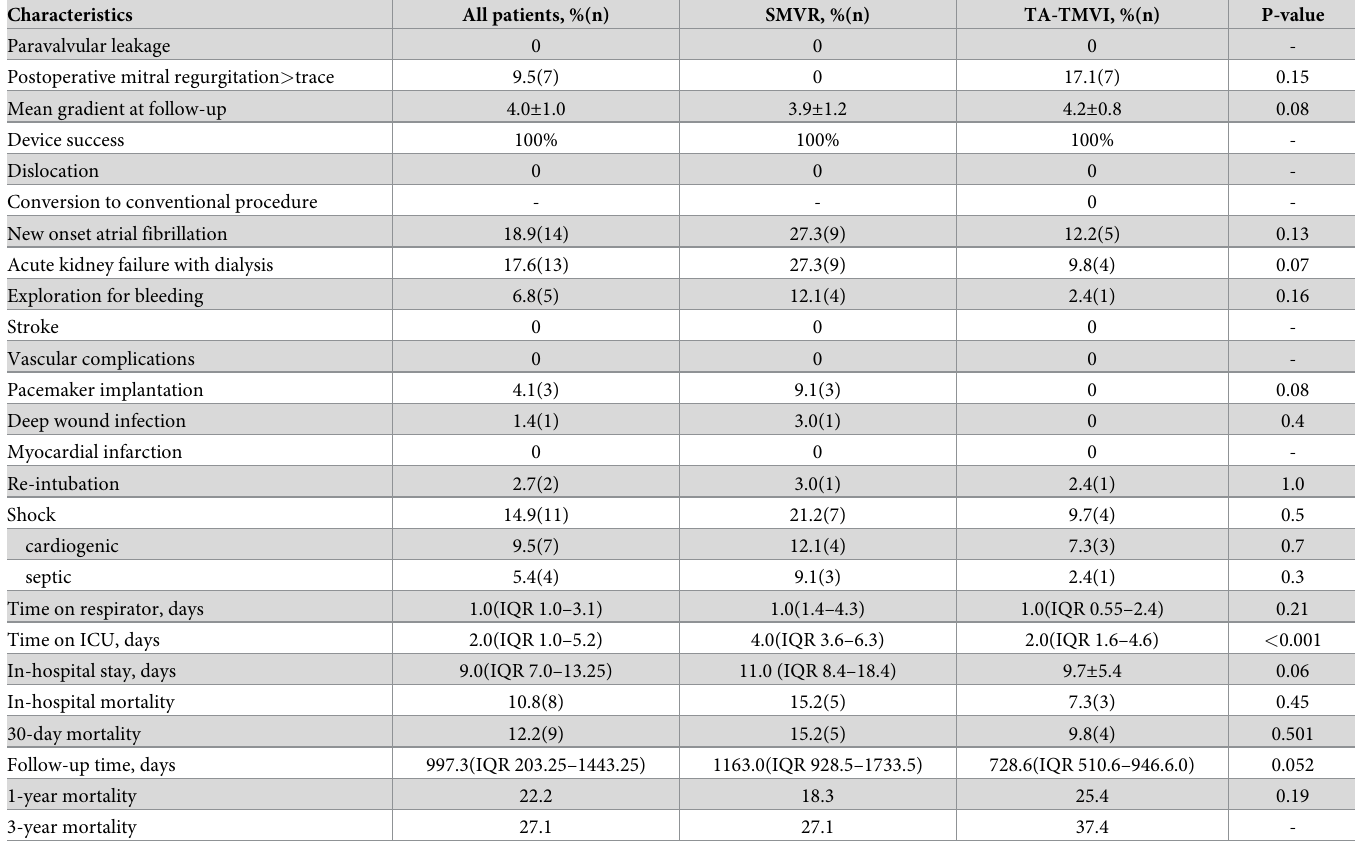
Table 3. Postoperative